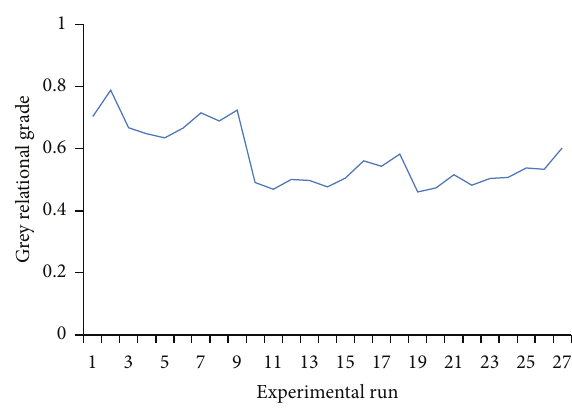
Figure 4: Grey relational